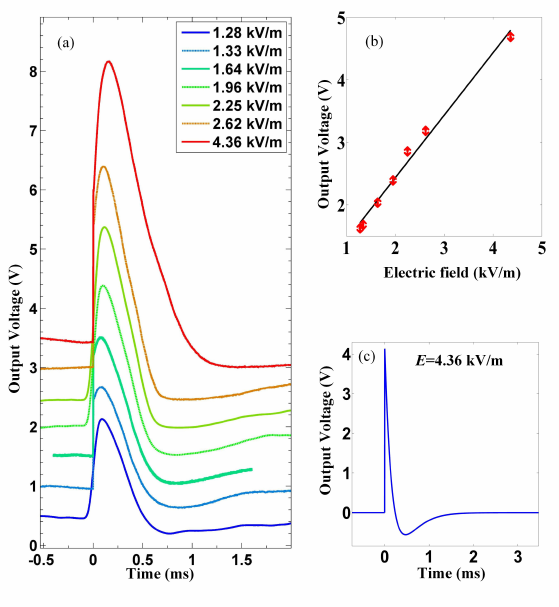
Figure 2. The measured and the calculated voltage response of the LiTaO 3 detector to short rectangular microwave responses, whose duration is kept at 2.2 µ s while the magnitude varies. In ( a ), the seven curves represent the voltage response at seven different peak field magnitudes below or equal to 4.36 kV/m, respectively. ( b ) shows the linear relationship between the the maximum of output voltage and the peak magnitude of the incident pulses. ( c ) shows the theoretical prediction of the detector’s voltage response to a pulse of 4.36 kV/m (with absorption coefficient η = 12%), whose magnitude agrees with that of the red curve in Figure